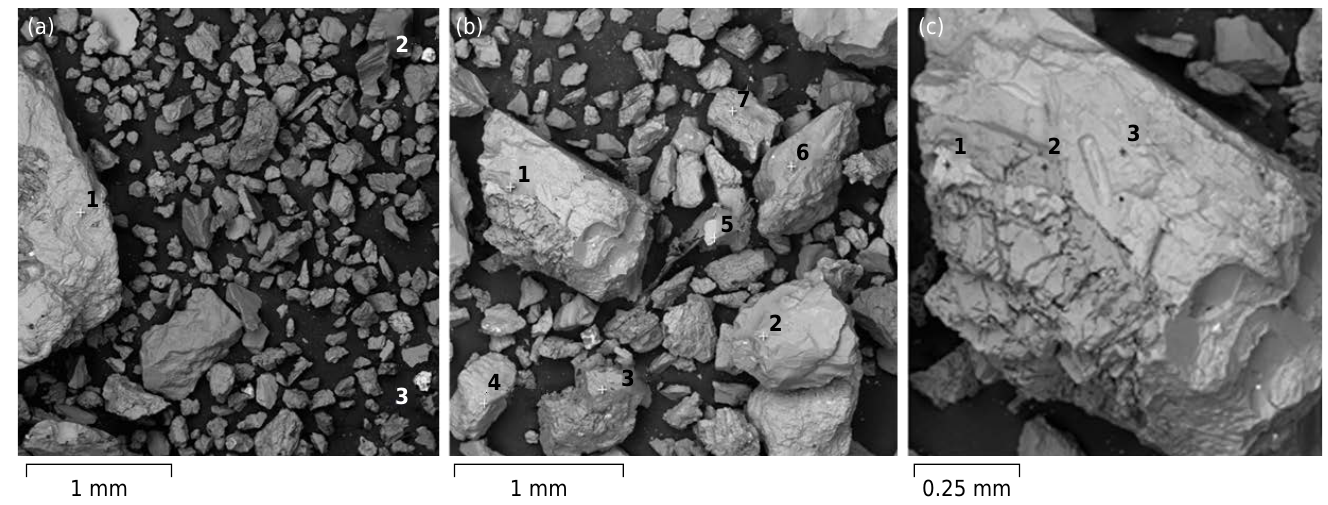
Figure 8. Scanning Electron Microscopy images of sand particles from sample